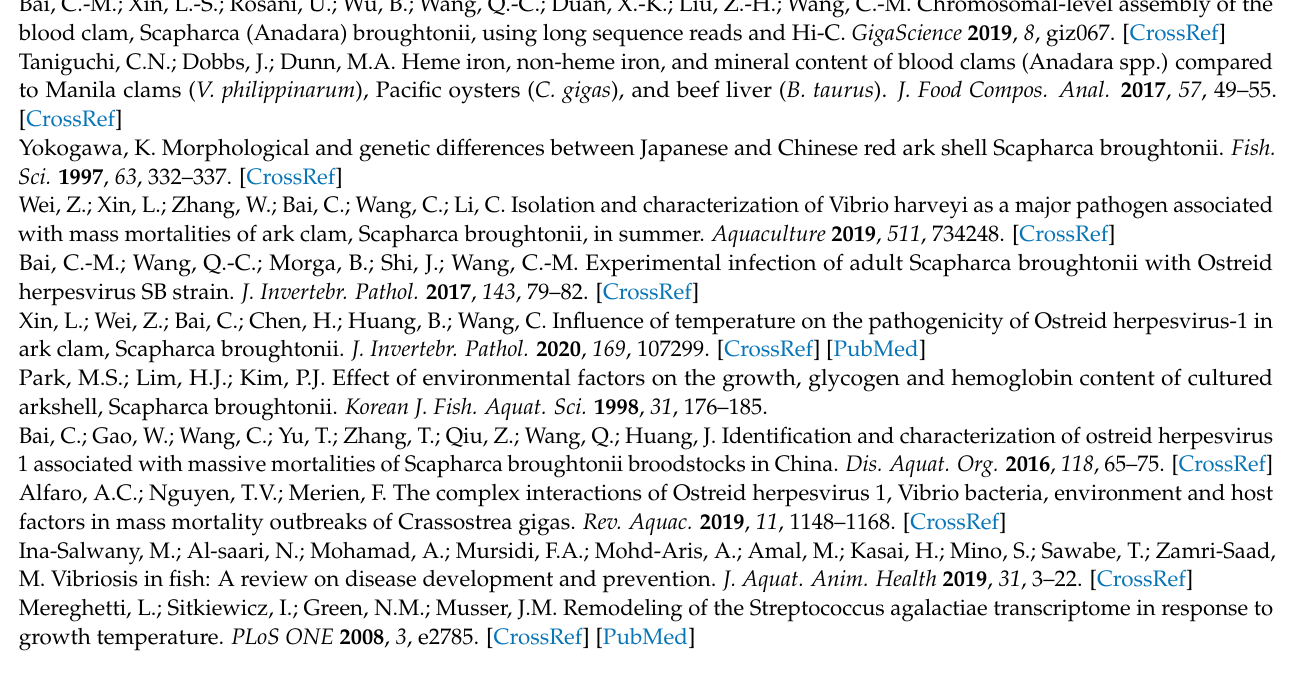
Figure S2. Growth of SbA1-1 in 2216E medium supplemented with different concentrations of DP at 15 ◦ C (A) and 25 ◦ C (B). Figure S3. Histology of adductor muscle and mantle tissues of ark clams after SbA1-1 infection at 15 ◦ C and 25 ◦ C. Figure S4. Specificity analysis of the nested PCR